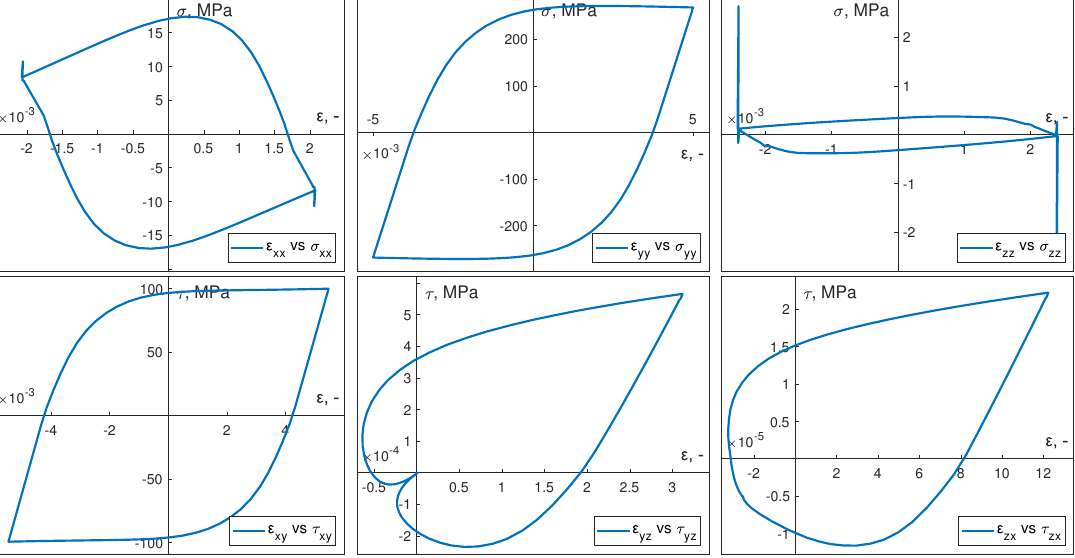
Figure 6. Numerical obtained hysteresis loops for in-phase kinematic